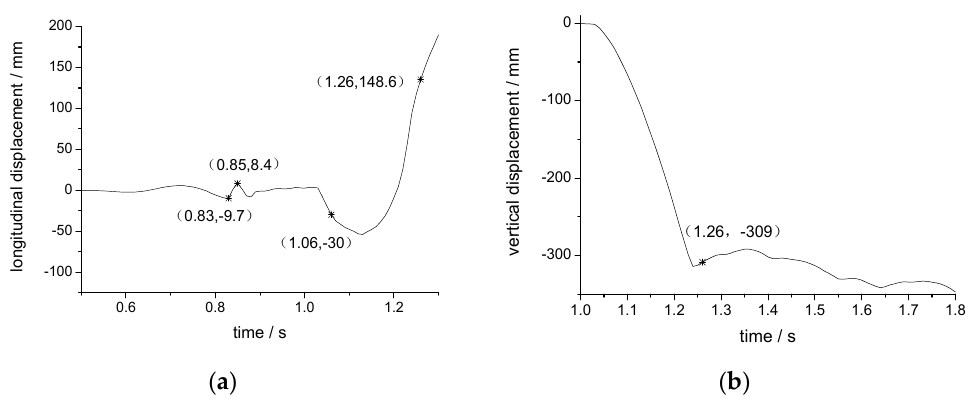
Figure 26. Time history curve of the top part of the middle pier: ( a ) longitudinal; ( b ) vertical.